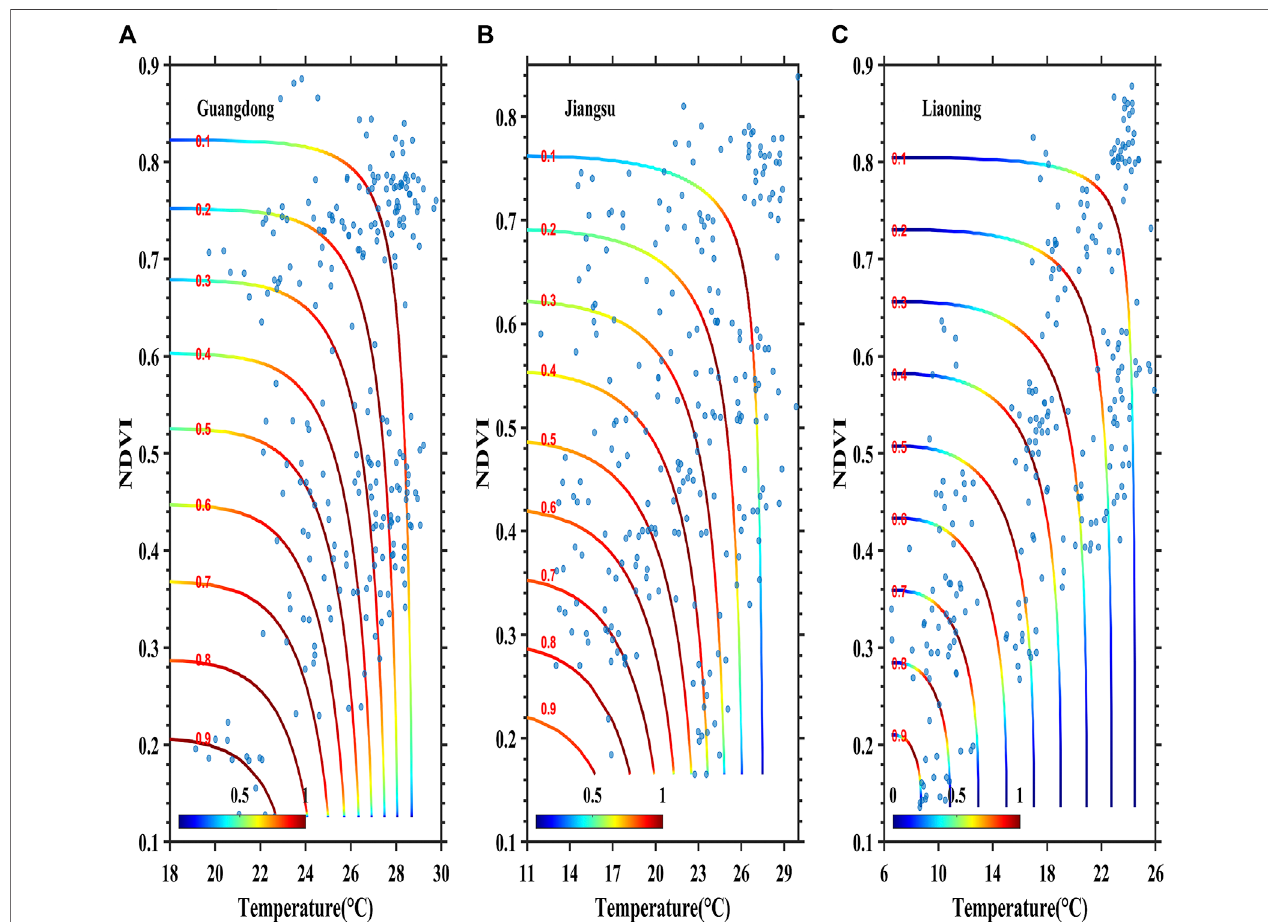
FIGURE 4 | Analysis of survival copulas of mean temperature-normalized difference vegetation index (NDVI) in (A) Guangdong, (B) Jiangsu, and (C) Liaoning.